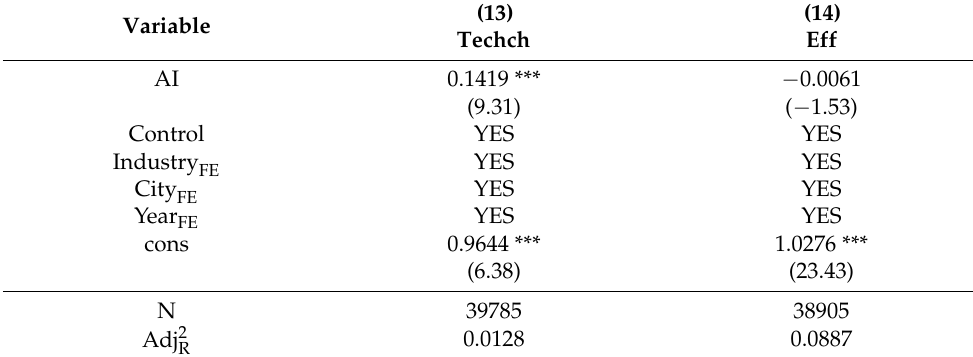
Table 7. Heterogeneity